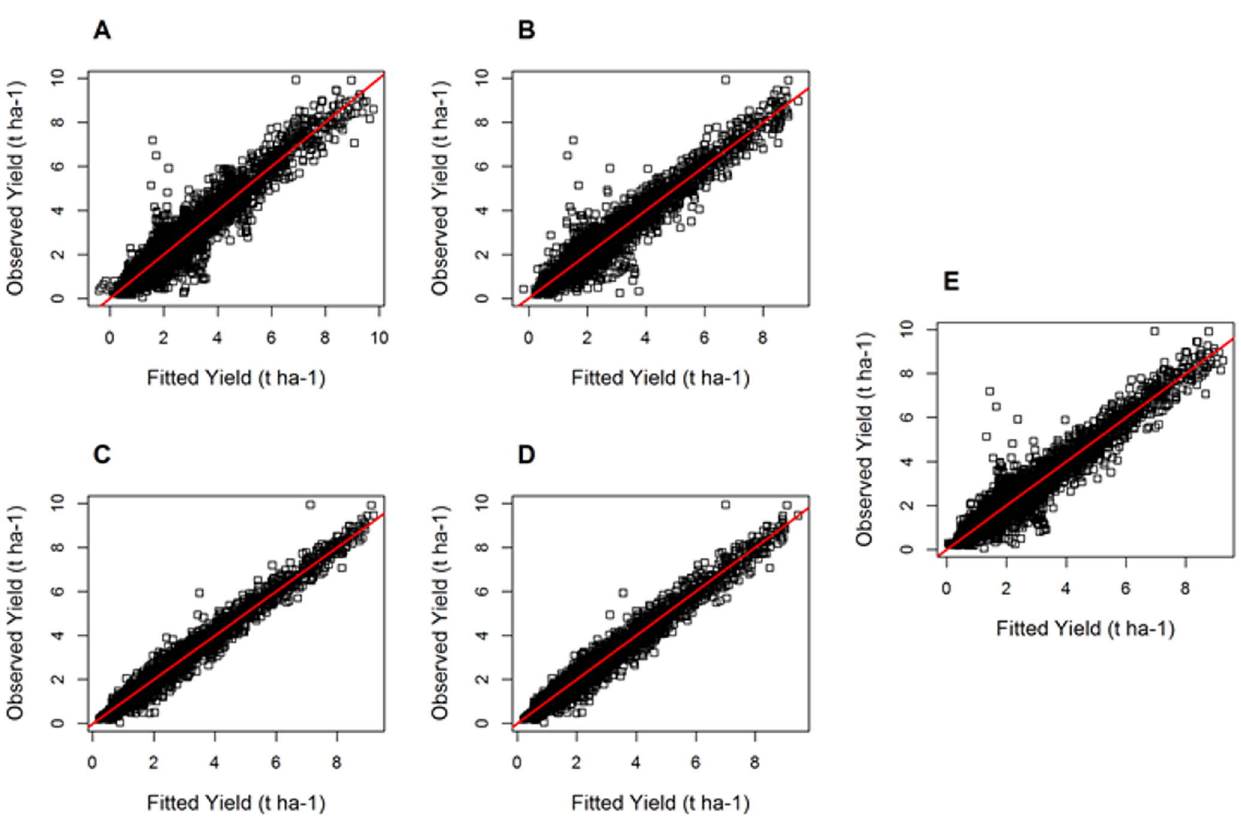
Figure 3. Wheat yield data versus fitted values for all countries and years of the Global dataset (dataset 1). A: Linear model. B: Cubic model. C: DLM0. D: DLMs. E: Quadratic model.